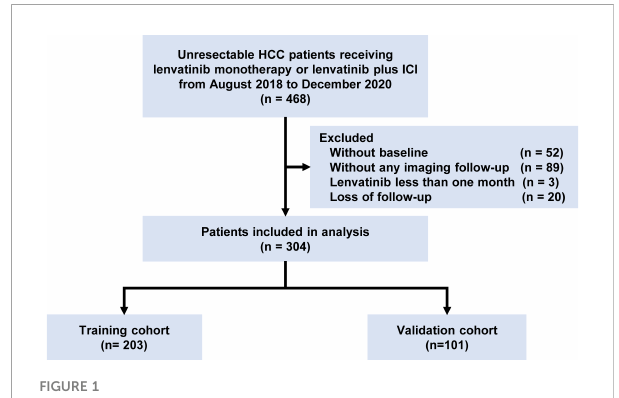
FIGURE 1 Flowchart of the study. HCC, hepatocellular